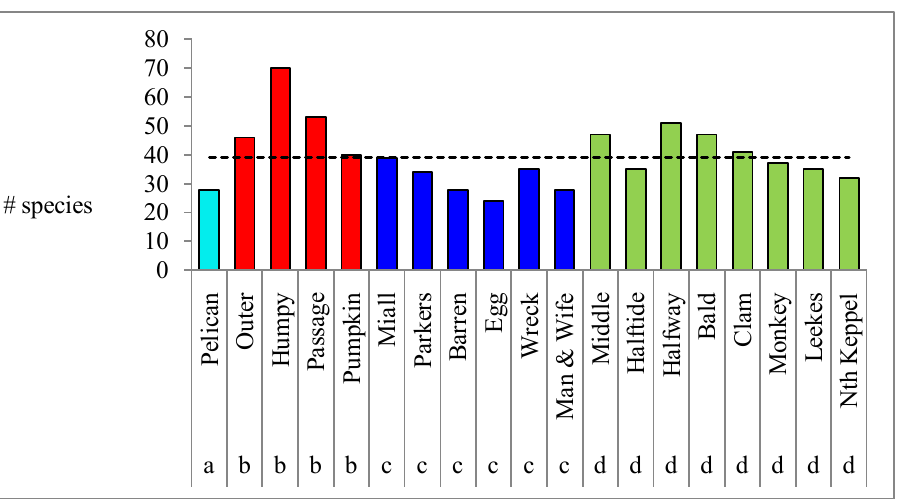
mean species number (39 species) for the 19 sites and bars represent the actual species number for individual sites. Aqua bars represent sites in group A, red bars represent sites in group B, blue bars represent sites in group C and green bars represent sites in group D.